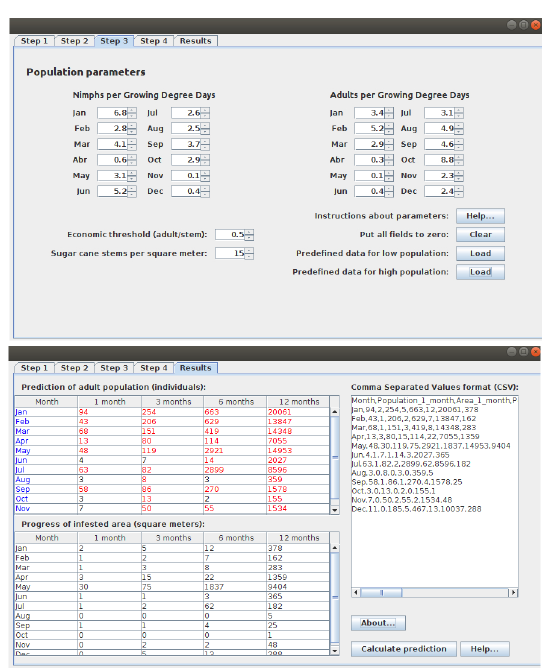
Figure 2. Upper part: Froghopper population calculation